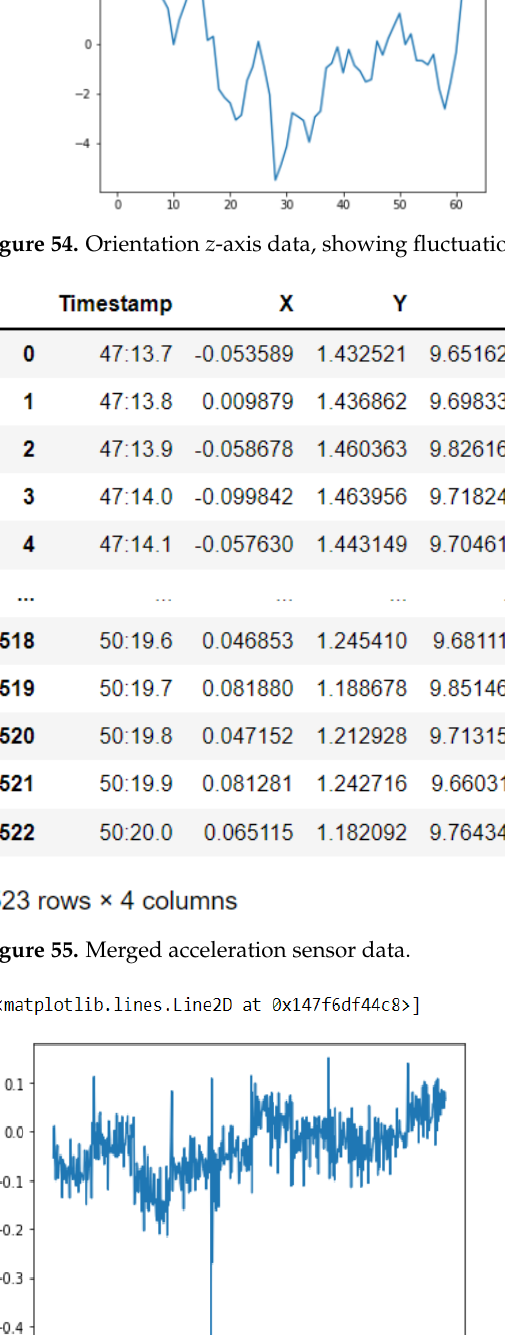
41 of 53 Figure 52. Data fluctuating between 78 and 86 at one fixed point. dataOrientationY=dataOrientation[ “ Y ” ] and dataOrientationY=plt.plot(dataOrientationY) were used similarly, in order to plot the y -axis data. We can observe that noisy data were obtained. Orientation can be measured as 180 degrees on the positive side when starting from the north direction, turning right towards the south direction. Meanwhile, a negative value is taken when turning left from north to south, with the same number (180). Thus, here, we use the value −12 to indicate a direction between north and west. The orientation of the user in Figure 53 is between −12 and −20.